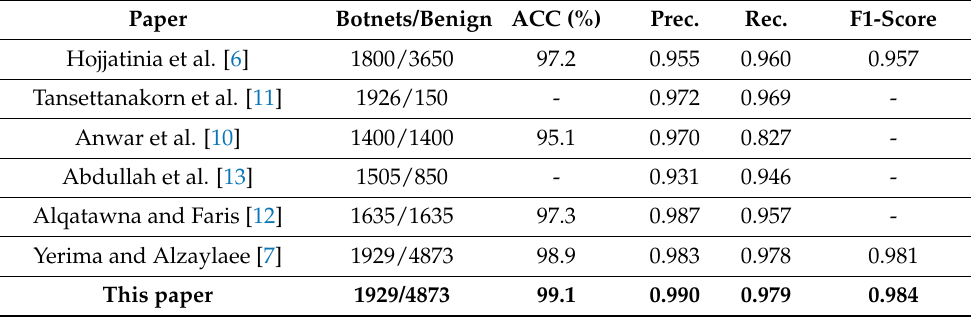
Table 9. Performance comparisons with previous works that utilize ISCX botnets samples.